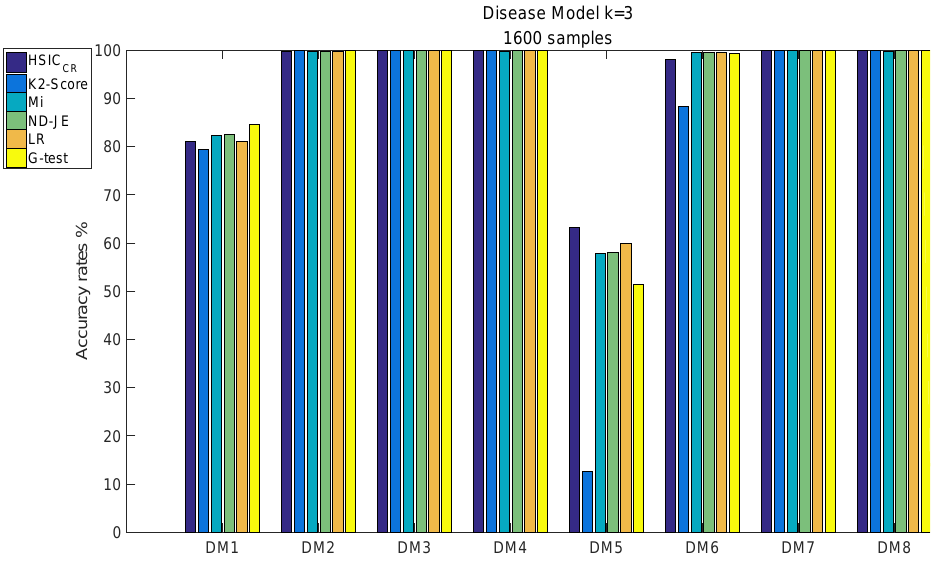
Figure 7. Disease model with 1600 samples and k =